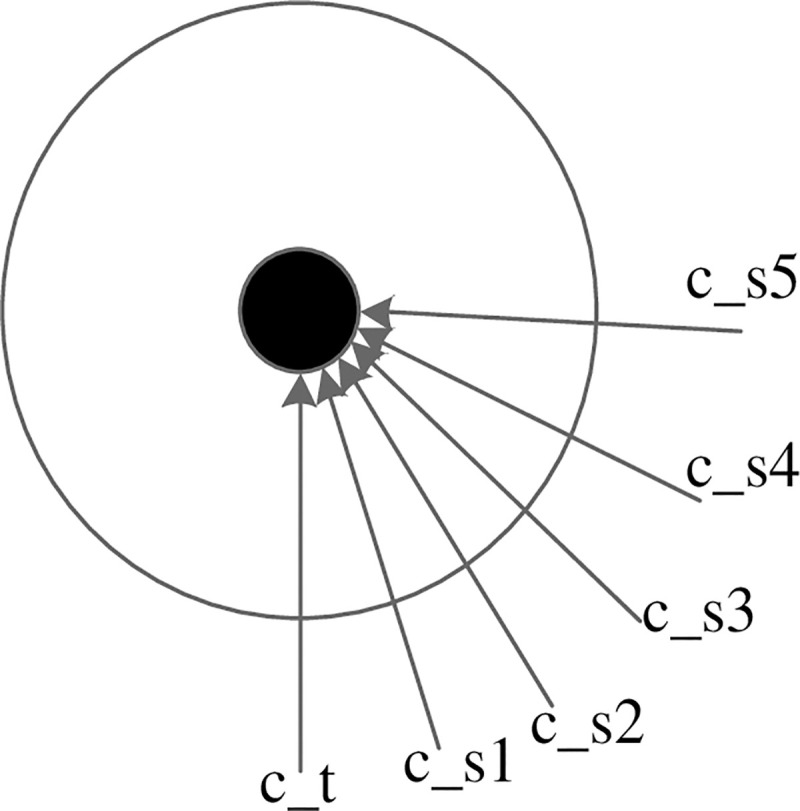
Six scan directions.